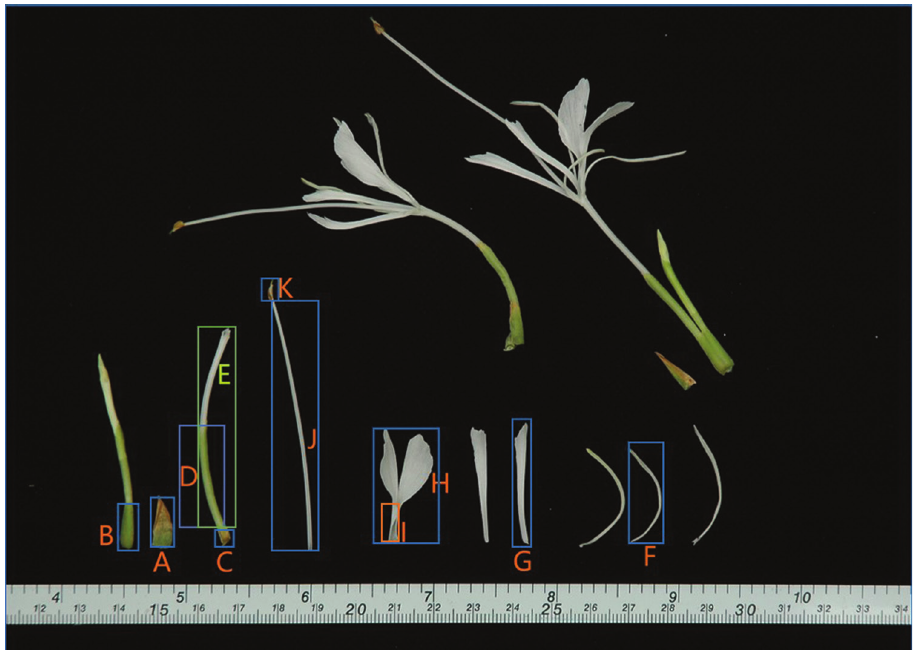
Figure 2. Hedychium viridibracteatum X.Hu, sp. nov., flowers and their parts: A bract B bracteole C ovary